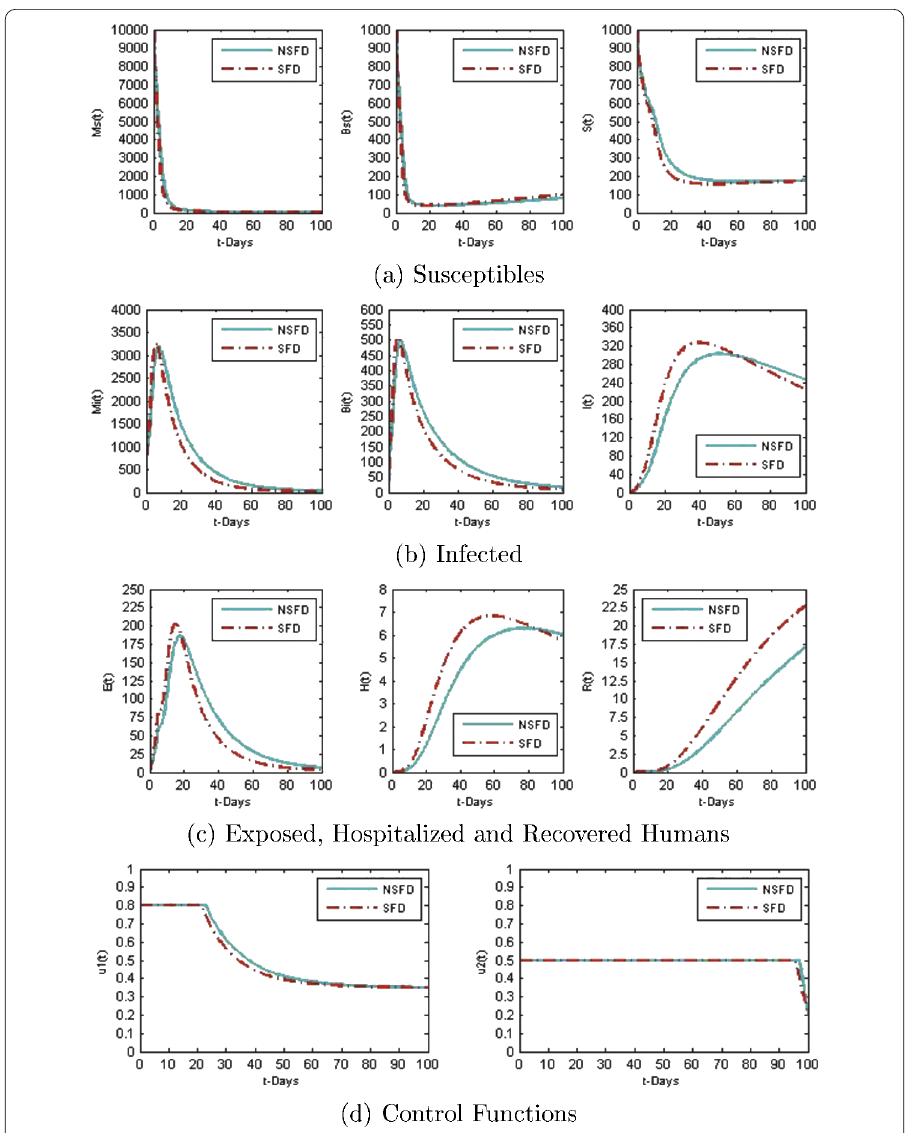
Figure 1 The approximate solutions of the fractional delay optimal control problem by using NSFDM and SFDM. When 0 ≤ u 1 ≤ 0.8, 0 ≤ u 2 ≤ 0.5, with d = 5 and α = 0.90, and (cid:7) t = 0.5